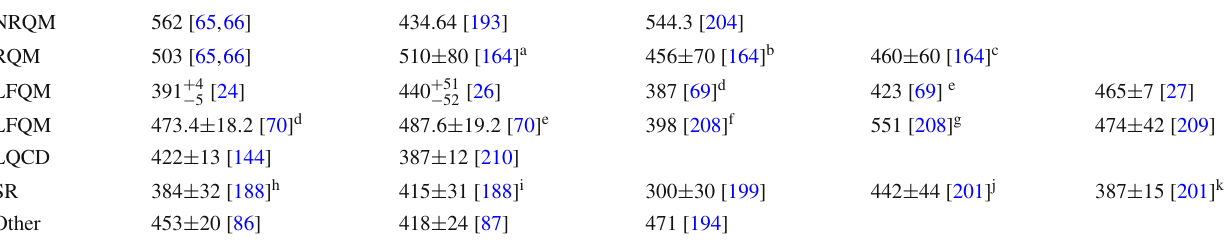
(in the unit of MeV), where the legends are the same as those in Table 3 c